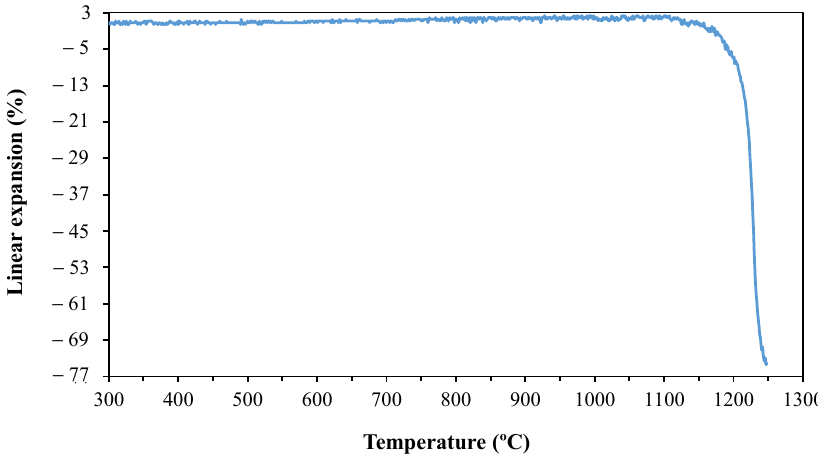
Figure 2. Linear expansion of basalt obtained by heating microscopy.